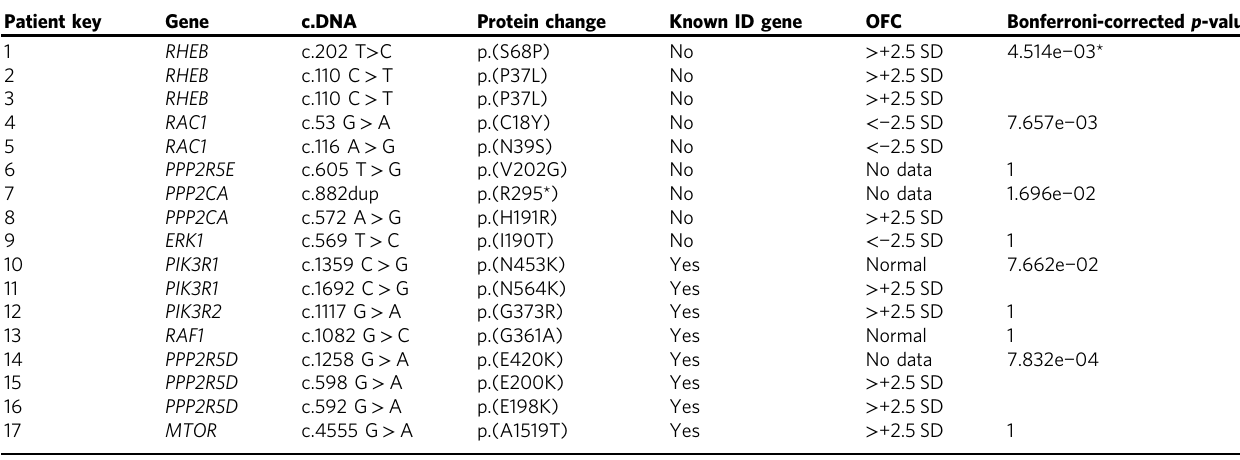
mutations in mTOR-related genes Patient key Gene c.DNA